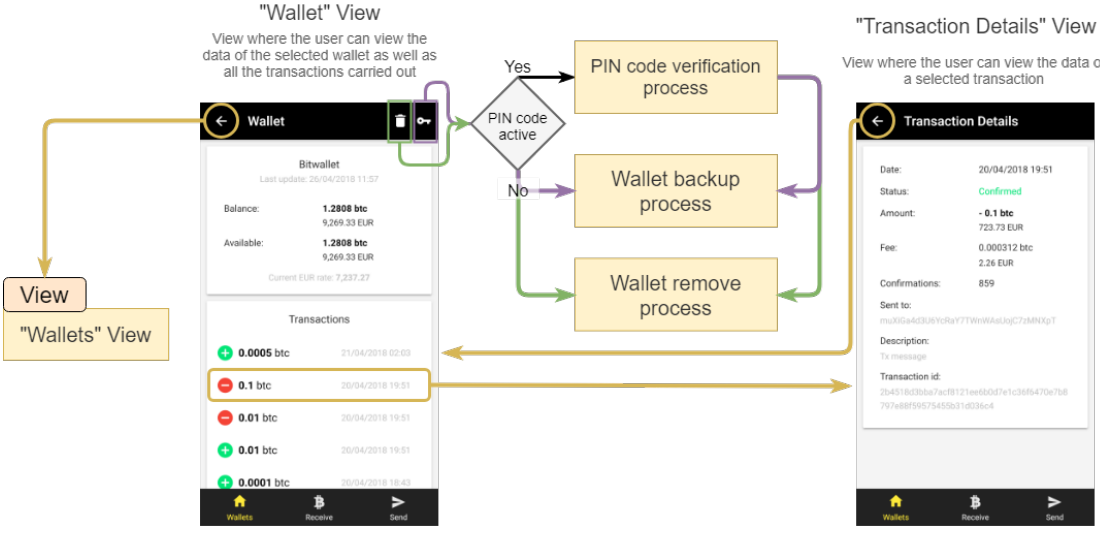
Figure 8. Navigability diagram of the “Wallet” view.